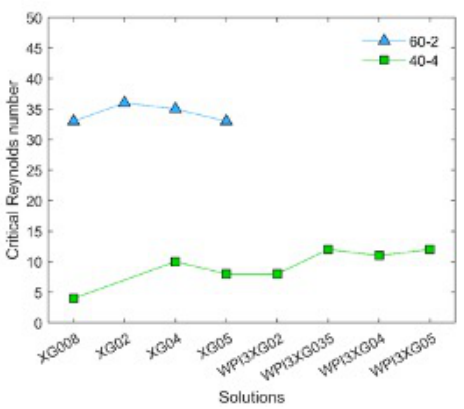
Figure 3: Critical Reynolds numbers for the two cone-plate geome- tries.